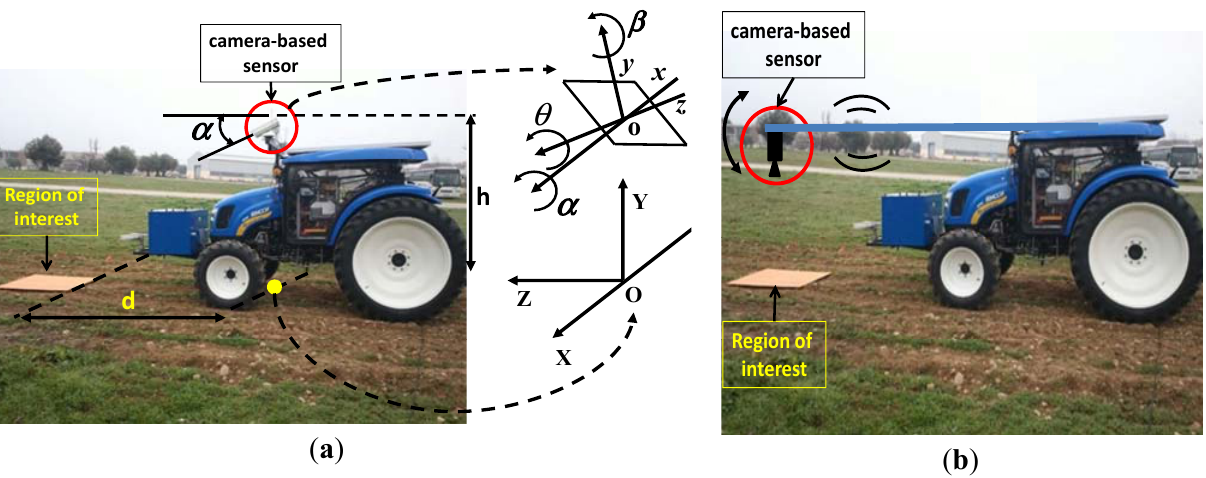
Figure 2. Camera-based sensor arrangement with a ROI in front of the tractor: ( a ) near the mass center of the tractor with referential coordinate systems; ( b ) Zenithal